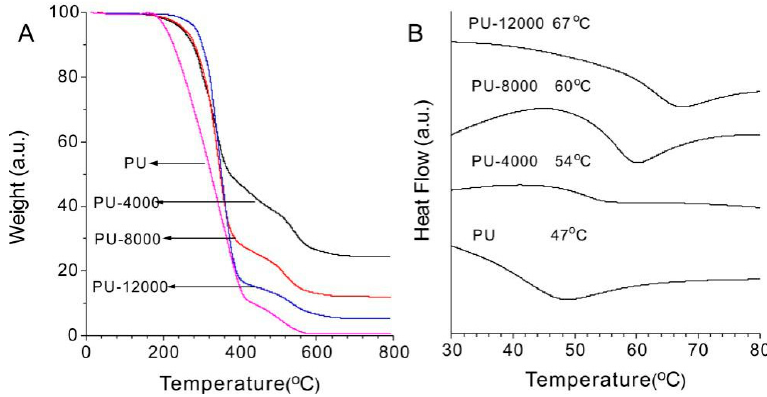
Figure 4. TGA curves of PU, PU-4000, PU-8000 and PU-12000 ( A ); DSC thermograms of PU, PU-4000, PU-8000 and PU-12000 ( B ). Table 1. Characteristics of PU, PU-2000, PU-4000 and PU-10000. Polyurethane